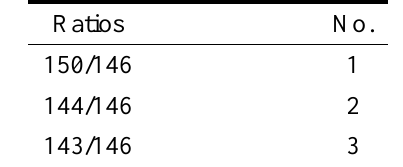
Ratio used for fractionation